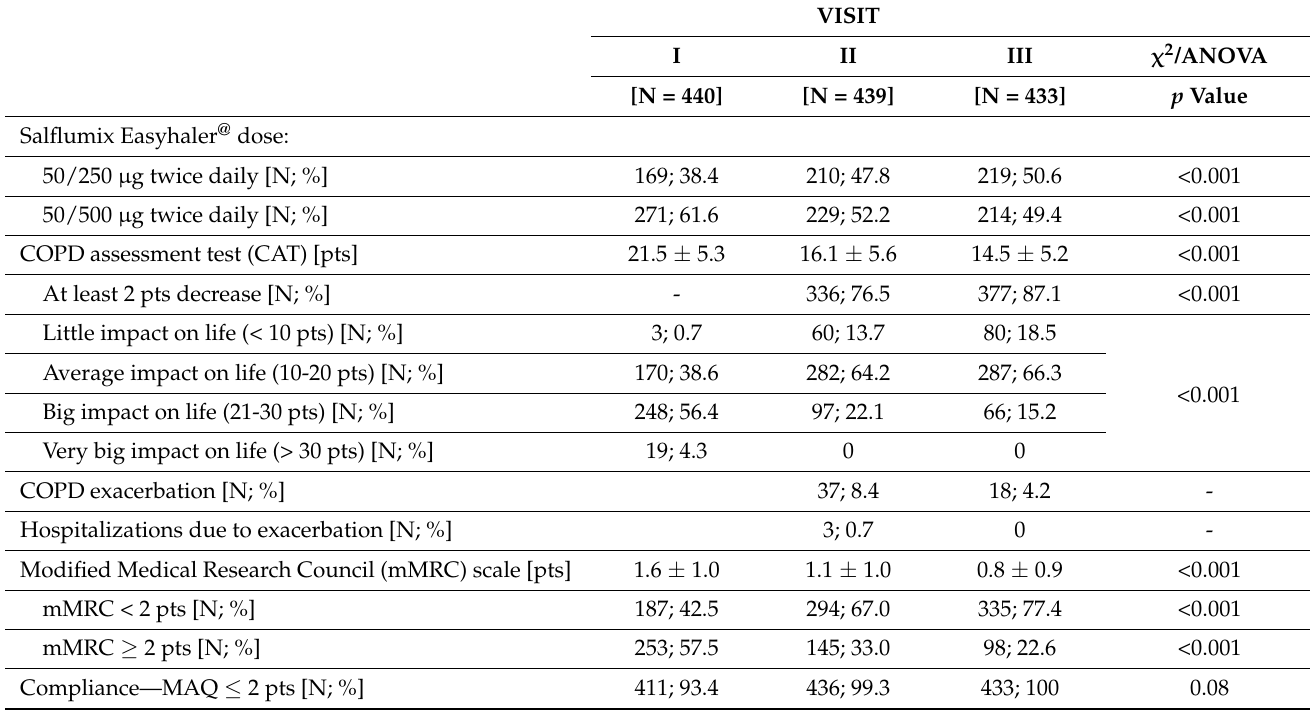
Table 2. Changes in the control of COPD during 3 visits (86 ± 30 days) in patients treated with Salflumix Easyhaler ®